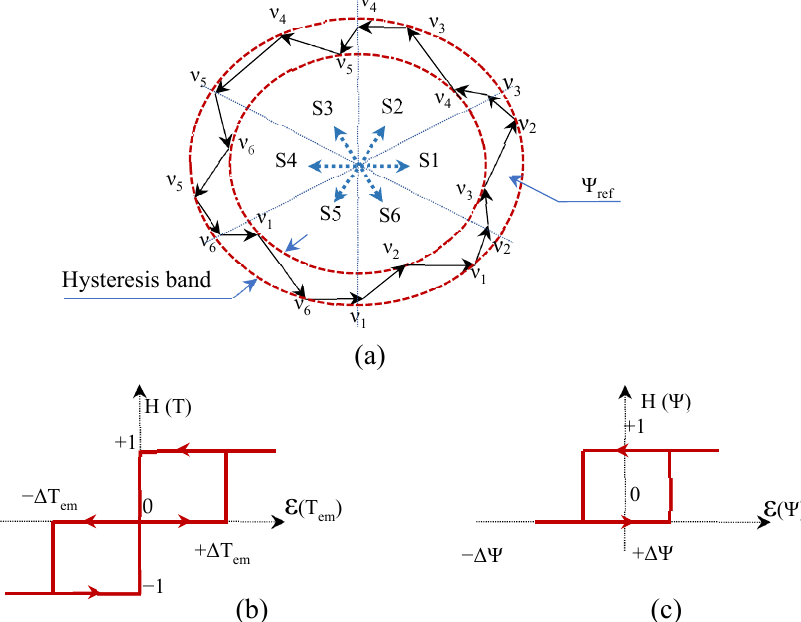
Figure 4. ( a ) Flux trajectory. Hysteresis comparators: ( b ) three − level torque, ( c ) two − level flux.